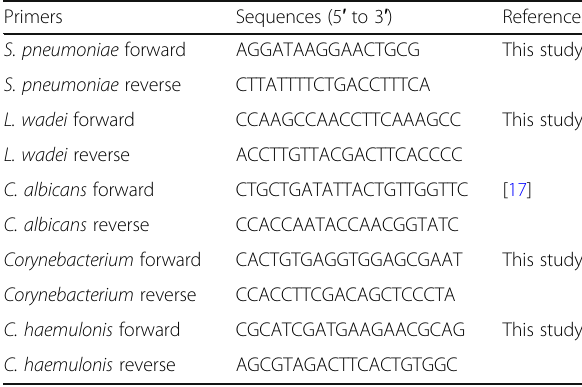
Table 4 Genus- and species-specific primers for confirmation of possible